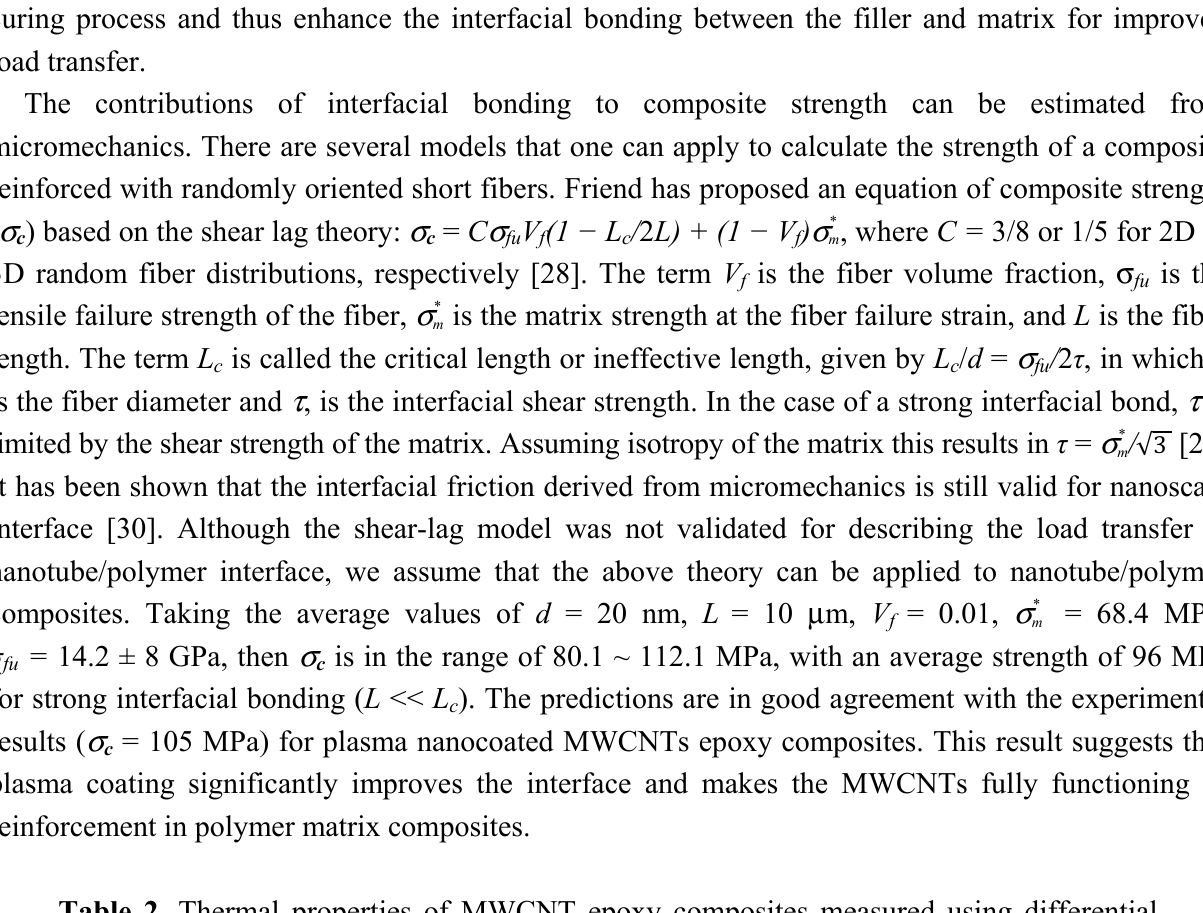
Table 2. Thermal properties of MWCNT epoxy composites measured using differential scanning calorimetry